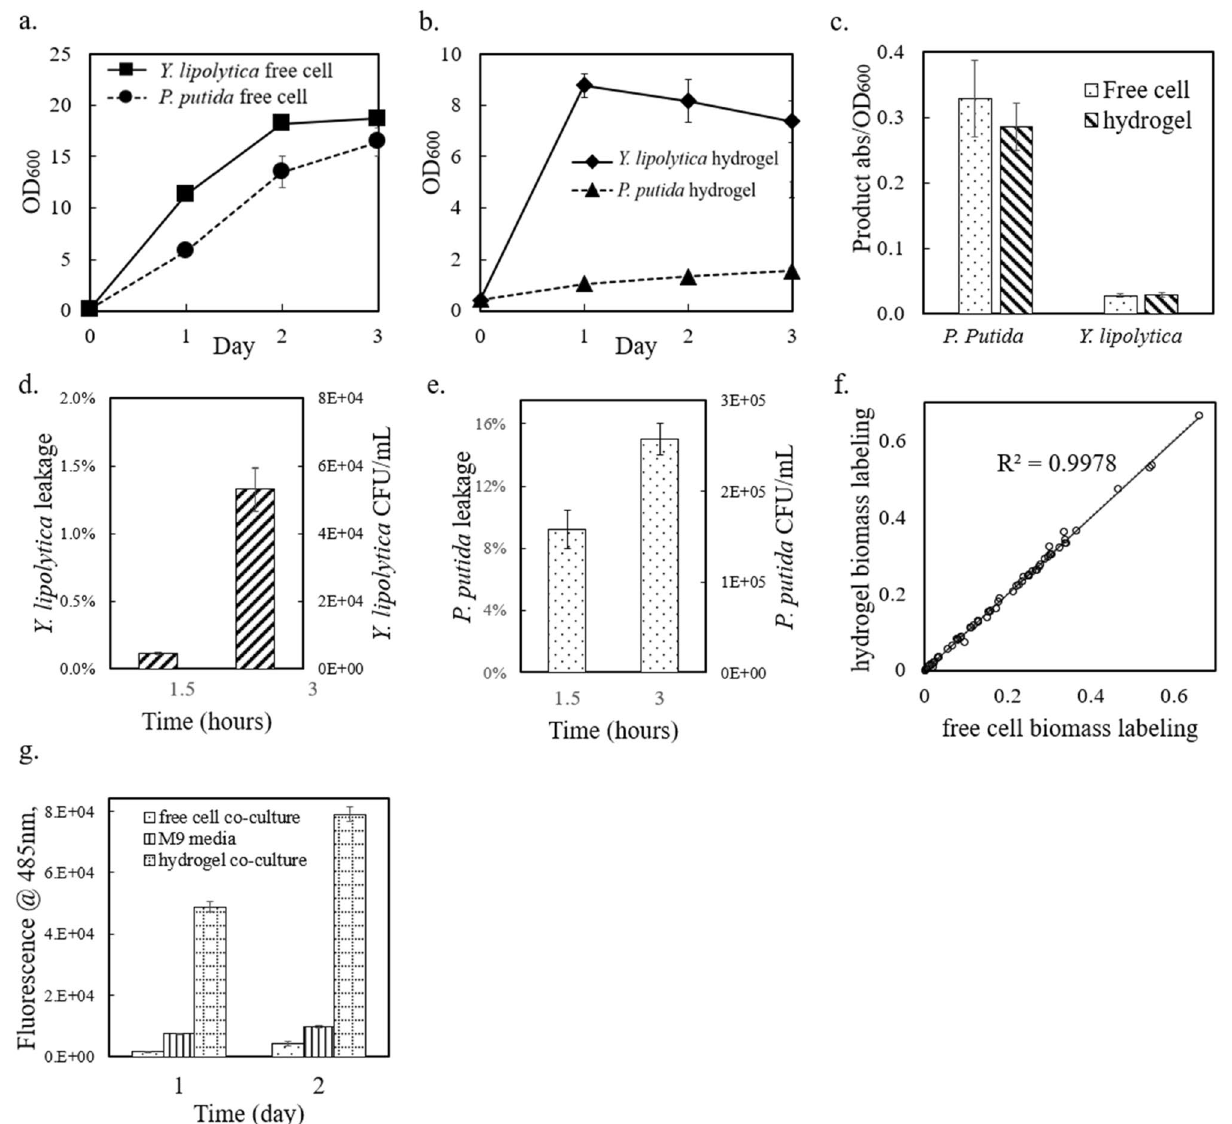
Figure 4. Heterotrophic culture behavior in rich media, with and without hydrogel compartmentation. ( a ) OD 600 measurements of heterotrophic strains growing as free cells over three days. ( b ) OD 600 measurements of heterotrophic strains growing in hydrogel compartmentation beads over 3 days. ( c ) Production of engineered P. putida (indigoidine) and Y. lipolytica (β-carotene) normalized to cell density. ( d ) Y. lipolytica cell leakage from hydrogel beads over 3 h, with shaking. ( e ) P. putida cell leakage from hydrogel beads over 3 h, with shaking. ( f ) 1,2- 13 C glucose labeling of Y. lipolytica proteinogenic amino acids from hydrogel and free cell cultures. The data points are from m/z = 57 peaks of GC–MS measurements of labeled amino acids. ( g ) Yellow fluorescent protein (YFP) fluorescence signal from engineered E. coli strain cultures (free cell co-culture, M9 media pure culture, and hydrogel co-culture). Data from plot ( a–e,g ) are averages of biological triplicates ± standard deviation. Some error bars are too small to be